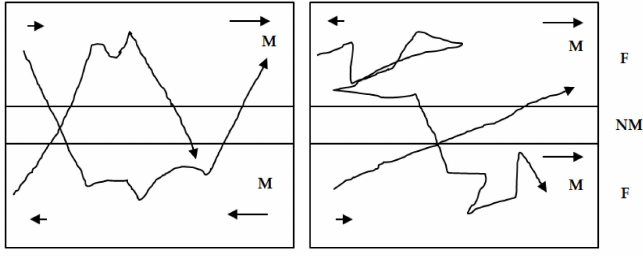
Figure 5. Schematic representation of the basic mechanism of the GMR by Kools